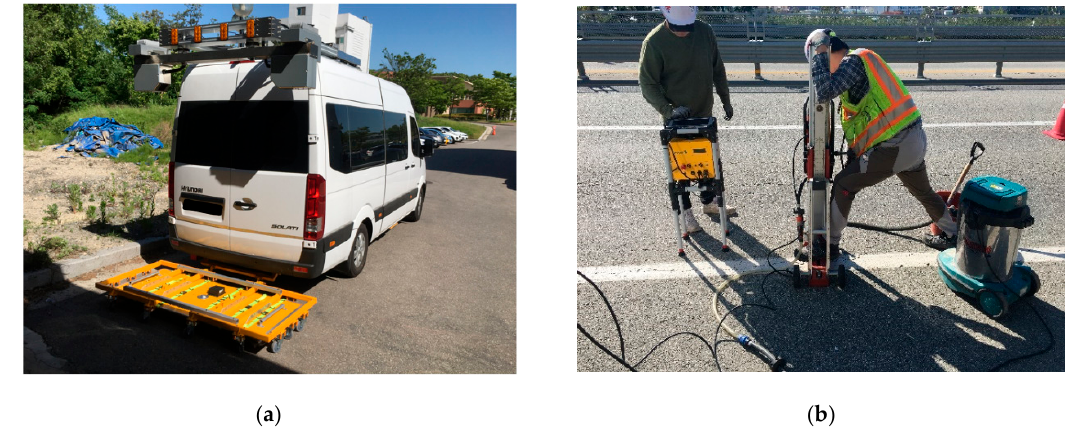
Remote Sens. 2019 , 11 , x FOR PEER REVIEW